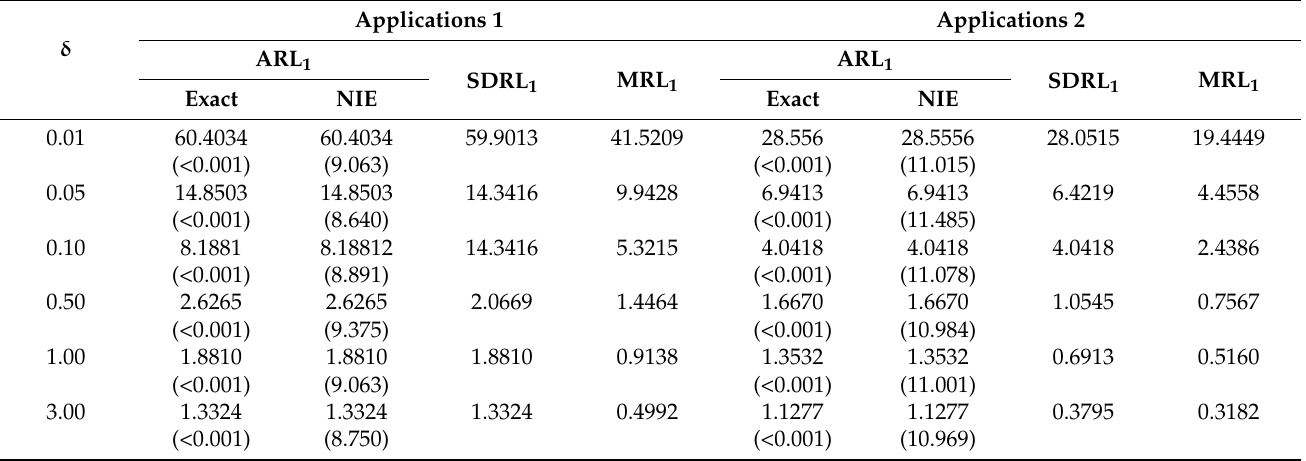
Table 9. Comparative ARL, SDRL, and MRL performance of EWMA and Modified EWMA charts for various shifts when λ =